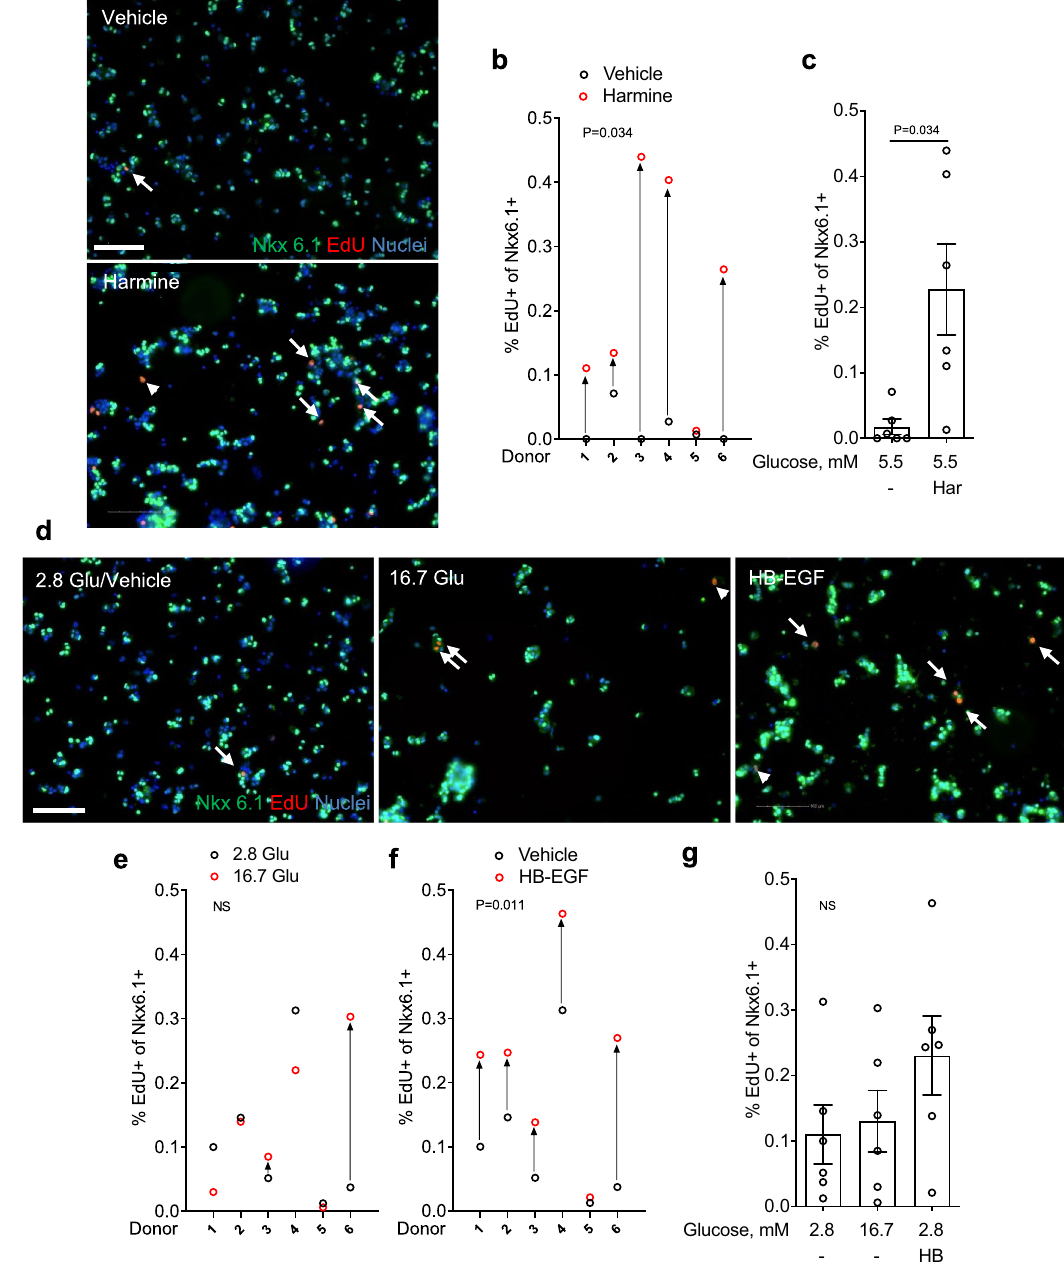
Figure 1. Analysis of β-cell proliferation in dispersed human islets by immunocytochemistry for Nkx6.1. ( a – g ) Dispersed human islets were exposed to 5.5 mM glucose (Vehicle; a – c ), 2.8 mM glucose (Vehicle or 2.8 Glu; d – g ), harmine (10 μM) (Har; a – c ), 16.7 mM glucose (16.7 Glu; d , e , g ) and HB-EGF (100 ng/ml) (HB; d , f , g ) for 72 h. EdU (10 μM) was added throughout. Proliferation was assessed by EdU staining and Nkx6.1 to mark β cells. Representative images of Nkx6.1 (green), EdU (red) and nuclei (blue) staining are shown ( a , d ). Arrows and arrowheads highlight EdU + /Nkx6.1 + and EdU + /Nkx6.1 − cells, respectively. Scale bar, 100 μm. Images were acquired using an Operetta CLS with Harmony 4.5 software (https:// www. perki nelmer. com/ en- ca/ produ ct/ opere tta- cls- system- hh160 00000). Between 1000 and 1500 Nkx6.1 + cells were counted for each sample. Proliferation is presented as the percentage of EdU + /Nkx6.1 + cells over the total Nkx6.1 + cells. Graphs showing cell proliferation of individual ( b , e , f ) and combined ( c , g ) donors were generated using GraphPad Prism 9 software (https:// www. graph pad. com/ scien tific- softw are/ prism/). Donor identifiers (Supplementary Table S1 online) are indicated. Significance was tested using paired t tests ( b , c , e , f ) or one-way ANOVA ( g ). P < 0.05 was considered significant. NS not